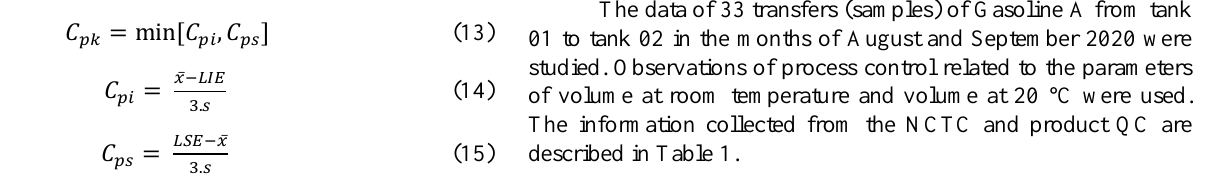
Table 1: Data collected from CACL and QC for transfers of Gasoline A (33 samples - August and September 2020).